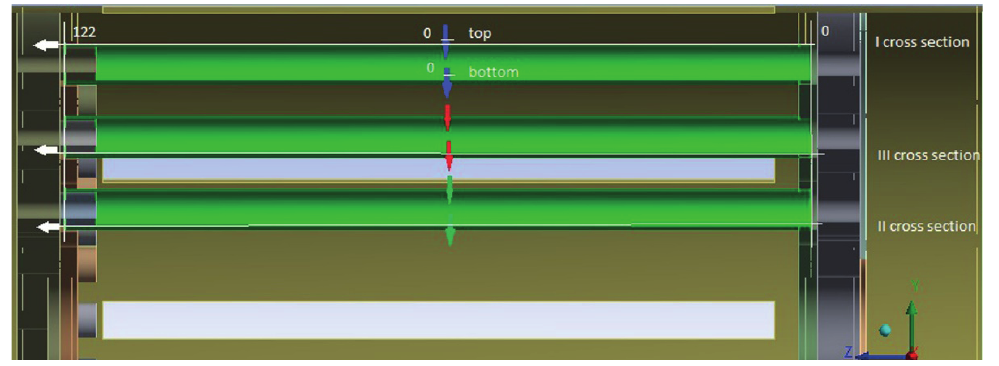
Figure 12: Selected half cross-section regions of the mSOFC stack geometry. The length distance is measured from the point marked “0” in direction of white arrows